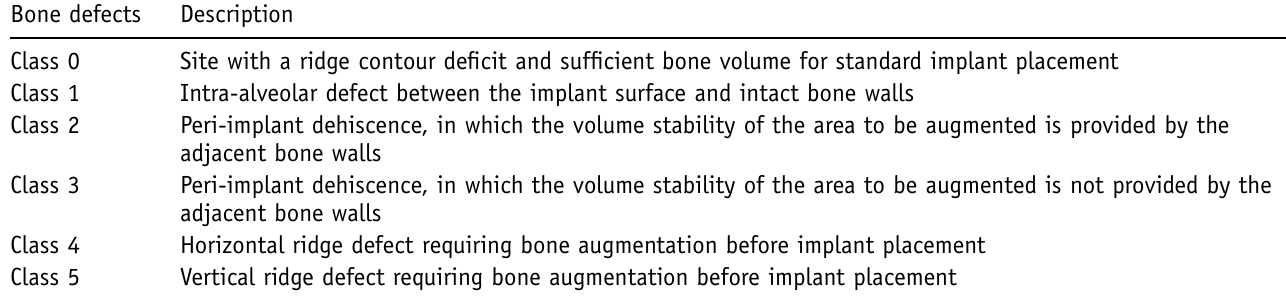
Table I. Bone defects according to Benic and Hämmerle. Bone defects